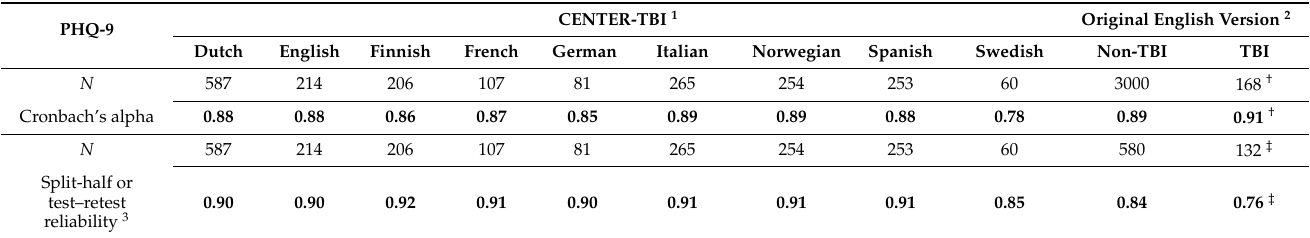
Table 2. Reliability of the PHQ-9: Comparison of the CENTER-TBI results with the values from the original English validation study and the first English validation study in the field of TBI.